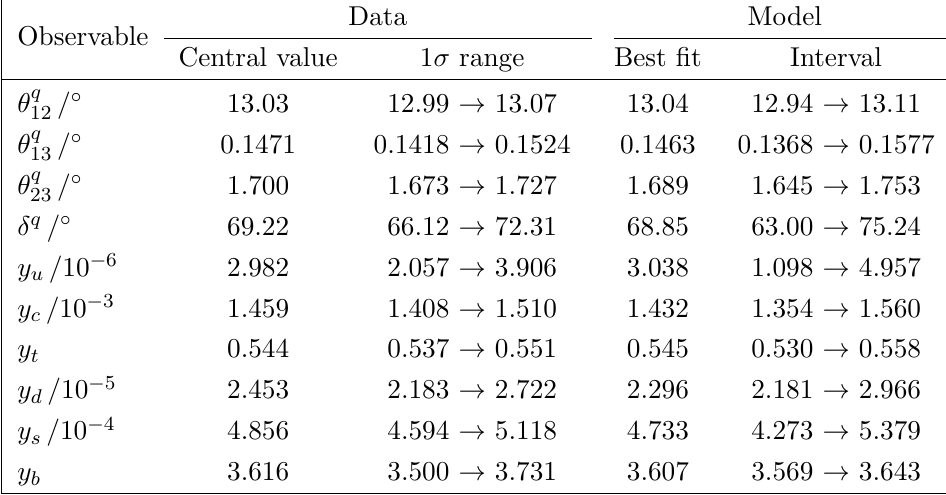
Table 8 . Model predictions in the quark sector at the GUT scale. We set tan (cid:12) = 5, M SUSY = 1 TeV and (cid:22) (cid:17) b = (cid:0) 0 : 24. The model interval is a Bayesian 95% credible